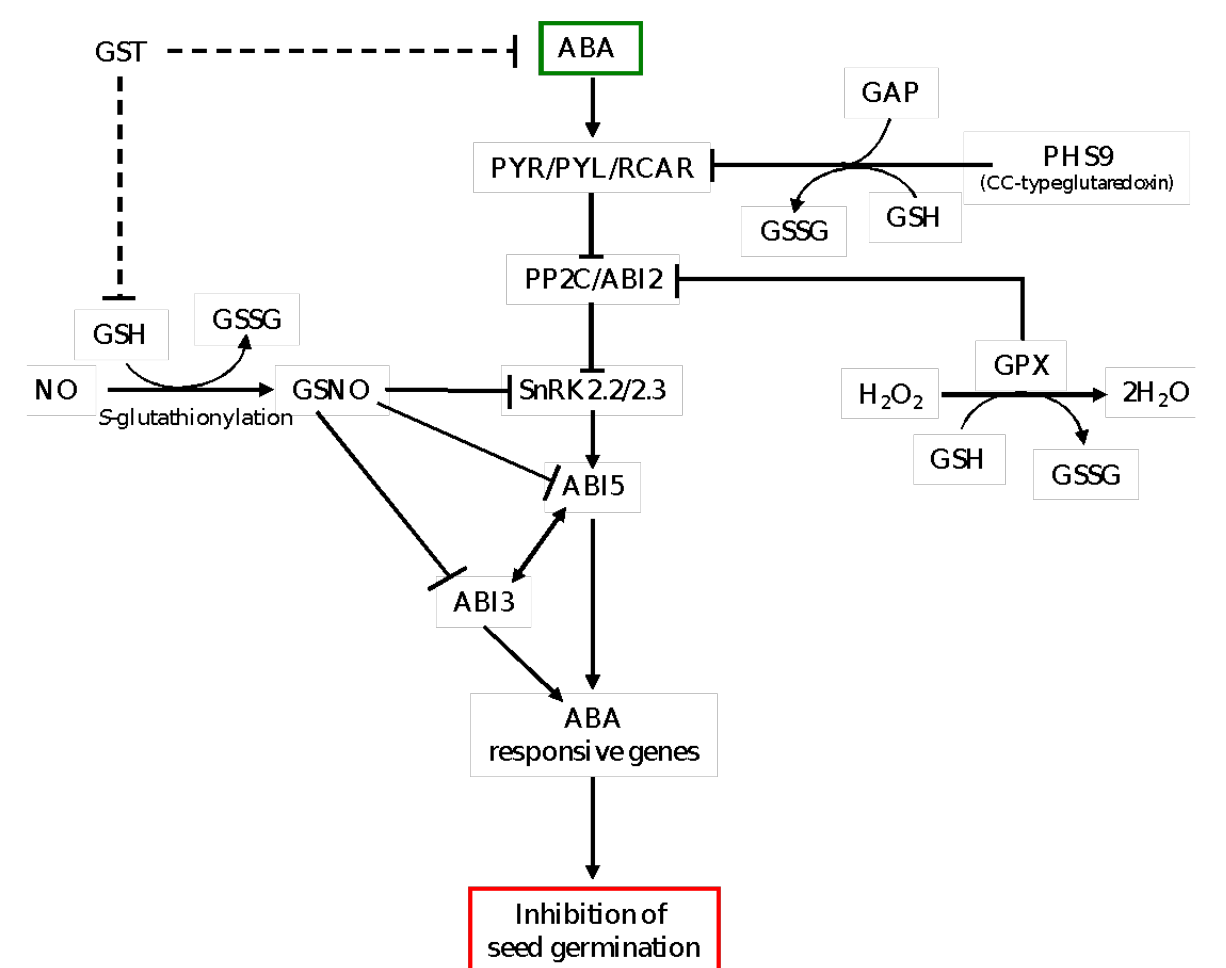
Figure 2. A model depicting GSH-mediated ABA signaling in the control of seed dormancy and germination. GSH in the presence of NO forms GSNO, which inhibits SnRK2.2/2.3 and ABI5 proteins of ABA signaling through S -nitrosylation, leading to repression of ABA signaling and promotion of seed germination. The CC-type glutaredoxin (PHS9) interacts with putative GTPase activating protein (GAP), which acts as an interacting partner of RCAR and inhibits PYR/PYL/RCAR, thereby repressing ABA signaling and enhancing seed germination. The GPX, which acts as antioxidant enzyme in maintenance of H 2 O 2 homeostasis, physically interacts with and inhibits ABI2, a negative regulator of ABA signaling, leading to activation of ABA signaling and inhibition of seed germination. GST is proposed to reduce the levels of ABA and GSH (broken lines); GSH suppresses the expression of ABA signaling genes and therefore induces seed germination. PYR/PYL/RCAR, pyrabactin resistance/pyrabactin resistance-like/regulatory component of ABA receptors; PP2C, type 2C protein phosphatase; SnRK, sucrose non-fermenting-1-related protein kinase; ABI2/3/5, ABA insensitive 2/3/5; NO, nitric oxide; GSNO, S -nitrosoglutathione; GST, glutathione S transferase; GPX, glutathione peroxidase; GSH, reduced glutathione; GSSG, oxidized glutathione.